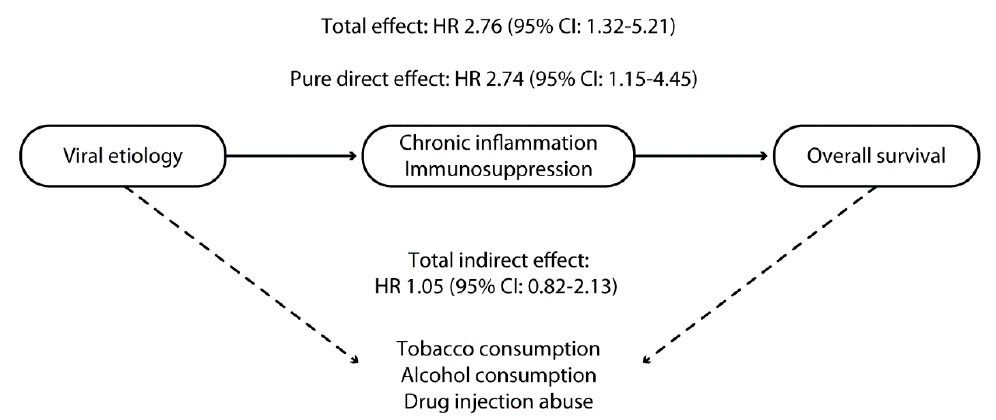
Figure 1. Directed acyclic graph reporting the assumed causal relationship between viral etiology and survival in patients with hepatocellular carcinoma treated with lenvatinib. The continuous line represents the direct effect of chronic inflammation and immunosuppression; the dotted line represents the indirect effect mediated by tobacco, alcohol consumption, and injection drug abuse. The pure direct effect (PDE), total indirect effect (TIE), and total effect (TE) of viral